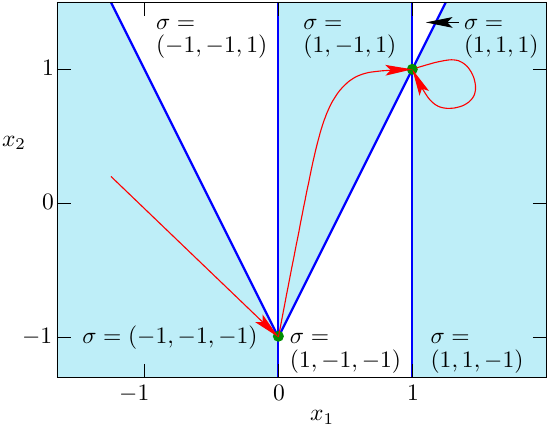
Figure 3. Signatures and reflection-based DCA for Nesterov–Rosenbrock variant (40) with n “